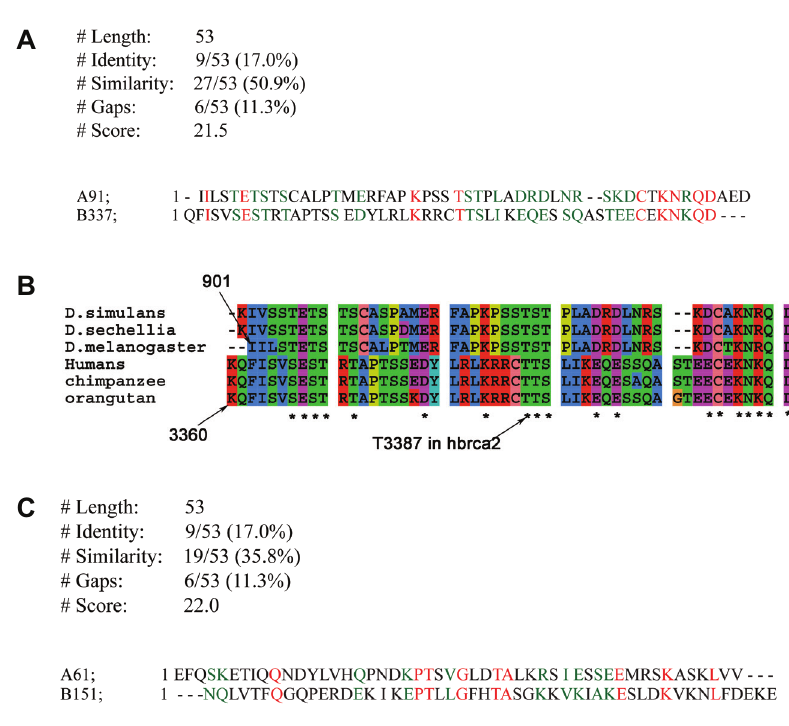
Figure 1. Fragment alignment using ‘needle’ from the EMBOSS suite 21 , 22 of previously unknown conserved, and functionally relevant, sequences in dmBRCA2. (red for identity, green for similarity). ( a ) Putative phosphorylation site by checkpoint kinases in the carboxy-terminal of hBRCA2. The threonine that is phosphorylated is highlighted (T3387 in hBRCA2 and T926 in dmBRCA2) (E=0.00091, Zscore=100). ( b ) Conserved sequence in the carboxy-terminal of the BRCA2 protein sequence: Checkpoint kinases Chk1 and Chk2 phosphorylate threonine 3387 in hbrca2, and is seen to be conserved in the mammalian and Drosophila species (T926 in dmBRCA2 ) . ( c ) Putative BRC repeat identified by the similarity of fragment 61 (634–664:LDTALKRSIESSEEMRSKASKLVVVDTTMR) in D. melanogaster to the BRC4 repeat in hBRCA2 (1517–1551) (E=0.0017, Zscore=95) (red for identity, green for